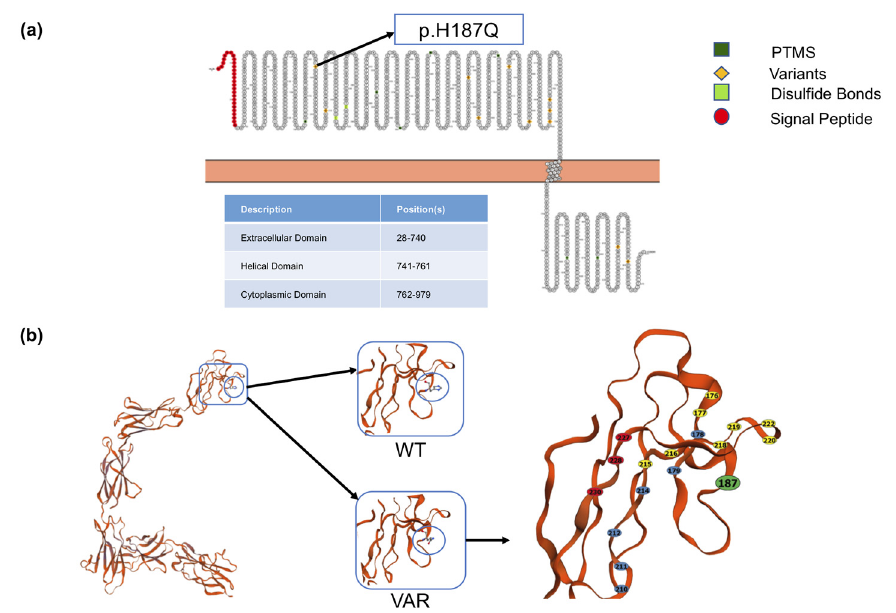
Figure 1. OSMR secondary and tertiary structure. ( a ) The OSMR extracellular, transmembrane, and intracellular domains are shown, as well as the protein AA sequence, as obtained with Protter. The post translational modifications (PTMs) and known variants are also detailed, including the p.H187Q SNP, indicated by an arrow; ( b ) the 3D prediction of the OSMR protein structure was obtained by the Swiss Model server using a homology method. The whole protein model is shown on the left, while the region around H187 is enlarged in the right, distinguishing between the wt (above) and the p.H187Q variant sequence (below). The region is further zoomed in to show the three hotspots sites around H187 reported by Du et al. [19] in yellow, blue, and red, respectively, with the Tyr214 residue being the hot spot binding residue in common between the three.